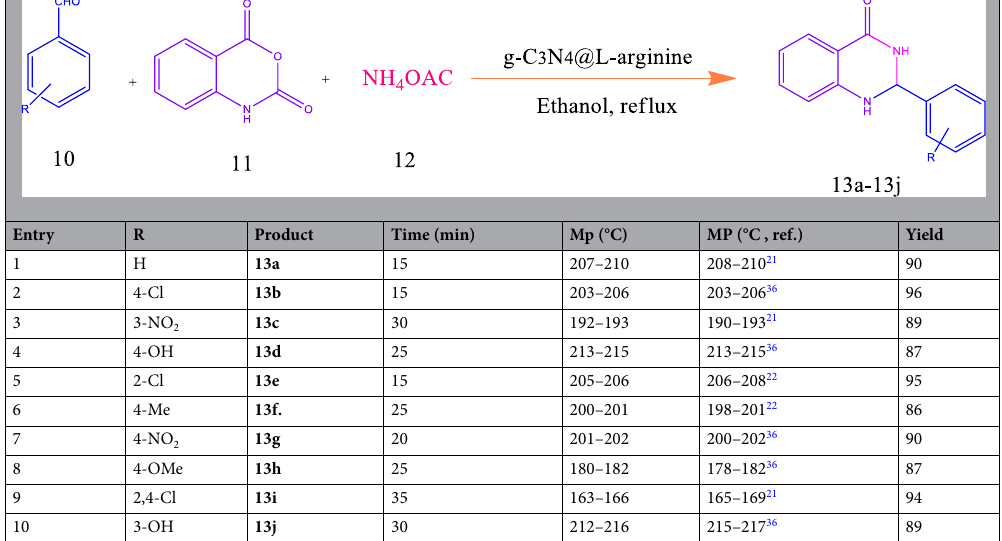
Table 4. Synthesis of 2,3-dihydroquinazoline derivatives using g-C 3 N 4 @l-arginine nanocatalyst. Reaction conditions: benzaldehyde (1 mmol), isotonic anhydride (1 mmol), and ammonium acetate (1 mmol),